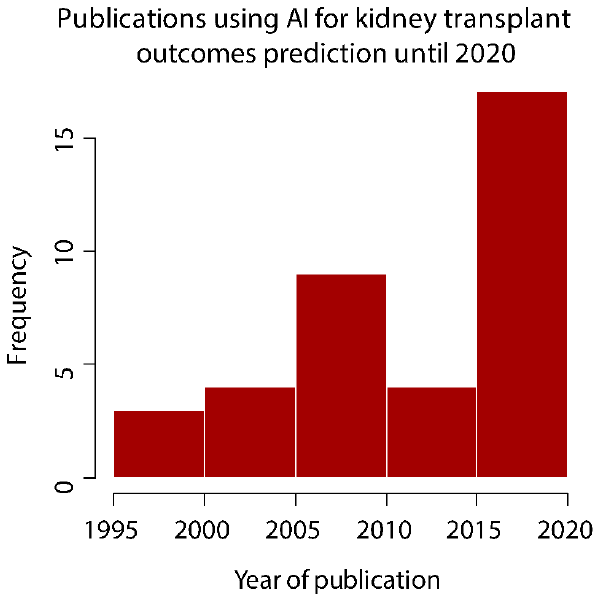
Figure 1. Publications using artificial intelligence to develop prediction models for kidney trans- plant outcomes.